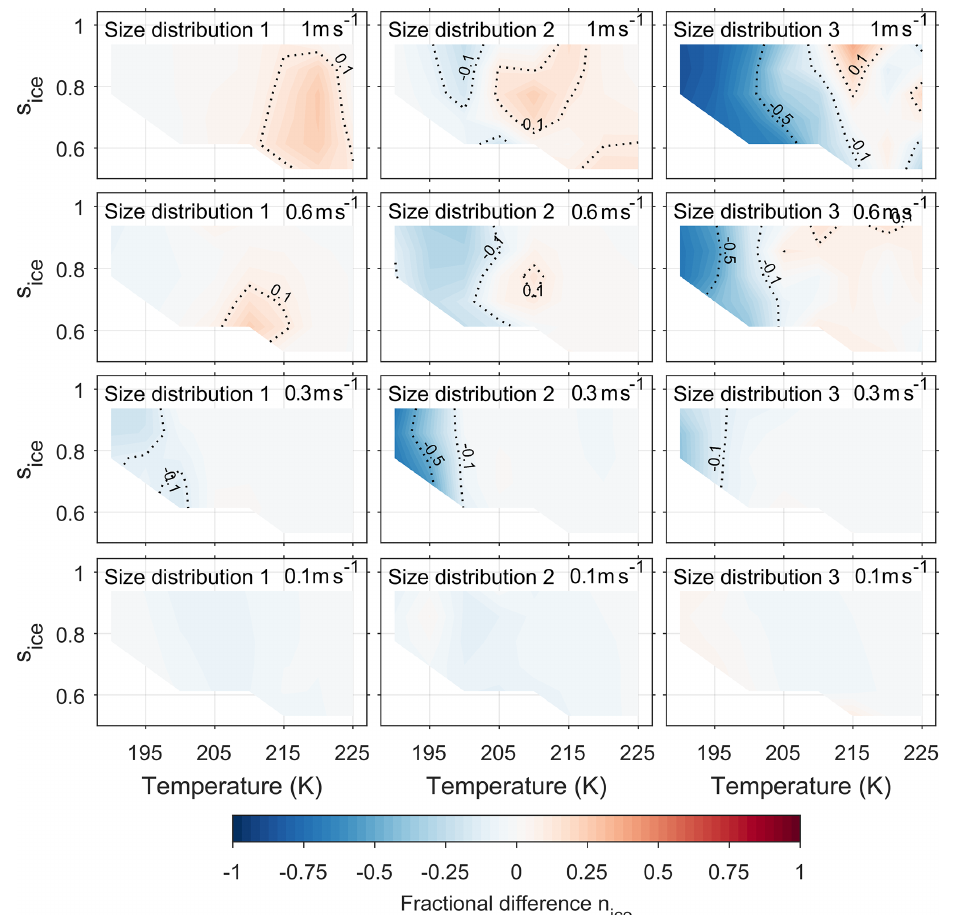
Figure 5. Shows the effect of initial conditions on the fractional difference in number of frozen particles between the new and control model simulations. The blue areas show that ice formation is suppressed in the new model simulations in comparison to the control model, and red regions show an enhancement in the number of frozen particles in new model simulations. Contours on the graph are labelled and highlight the 0.1 and 0.5 fractional suppression and enhancements by the new model compared to the control model. The models have been initiated with three different size distributions, which are given in Fig. 2, and with constant updraft velocities ranging from 0.1 to 1ms − 1 . Figures showing the number density of ice crystals formed in the new and the control model simulations are available in the